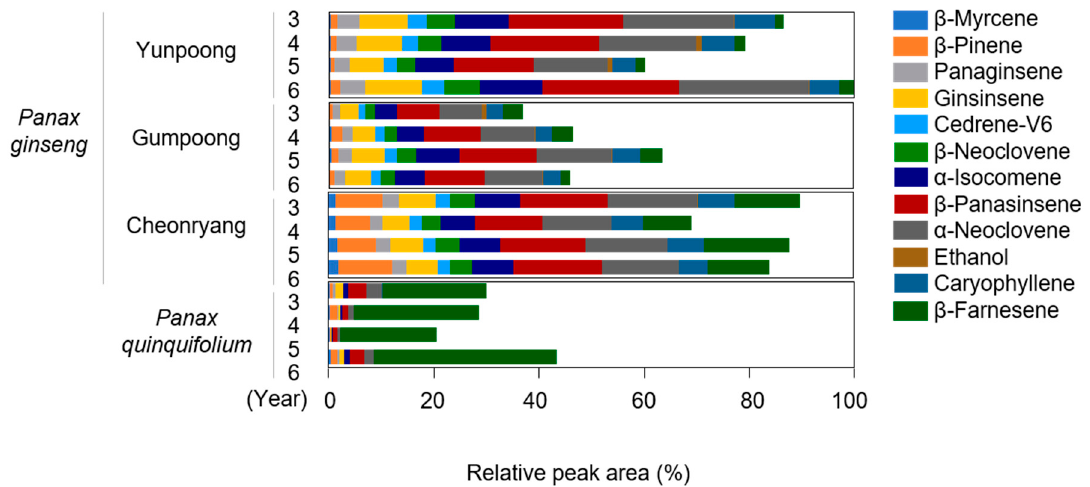
Figure 4. Profiles of the major discriminant volatile compounds identified in the four different white ginseng roots grown for 3–6 years. The tentative concentrations of volatile compounds are relatively indicated as percentages based on the total peak area (100) in the 6-year-old ‘Yunpoong’ cultivar. Data are provided as mean values ( n = 3 biological replicates).